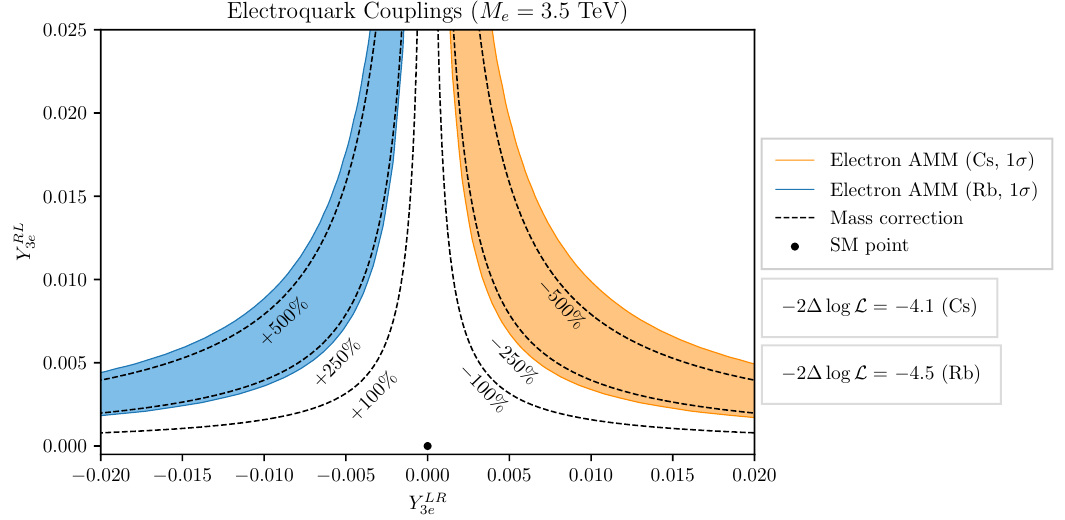
and Y RL . We 3 e 3 e e